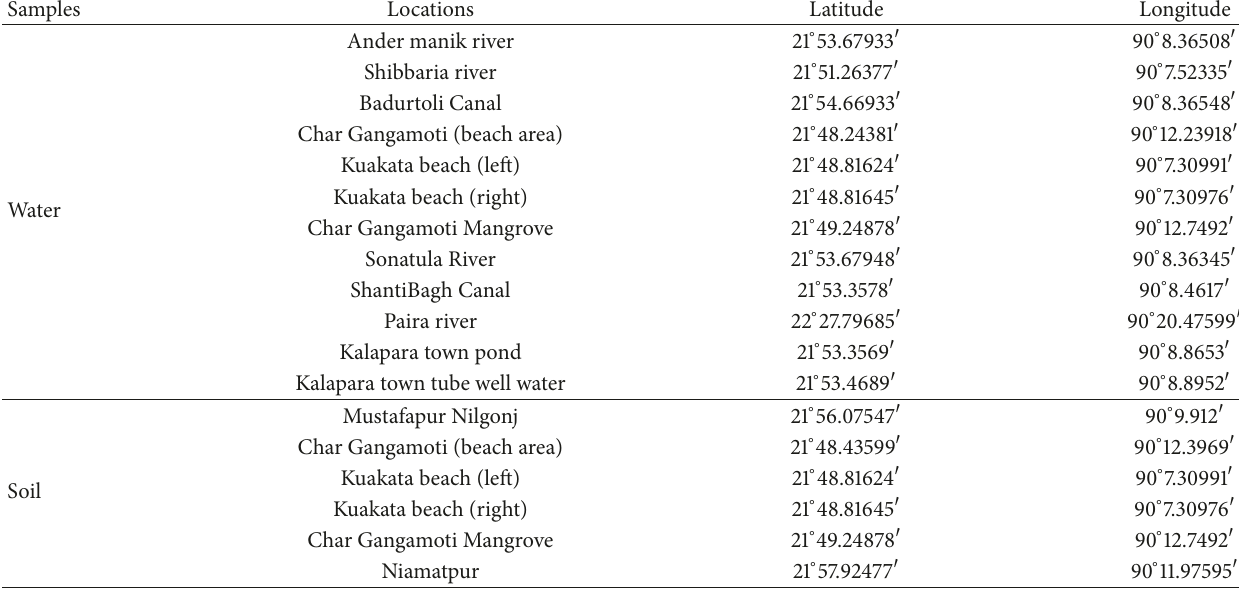
Table 1: Geographical position for water and soil sampling study areas across the coastal belt.